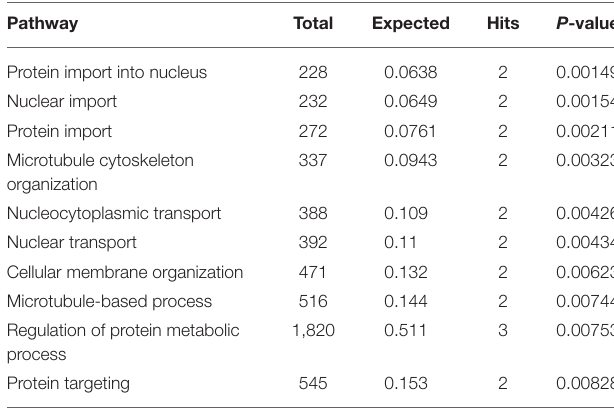
TABLE 1 | Pathways enriched by proteins and metabolites in subnetwork 1 of the protein–metabolite interaction network based on the GO:BP database. Pathway